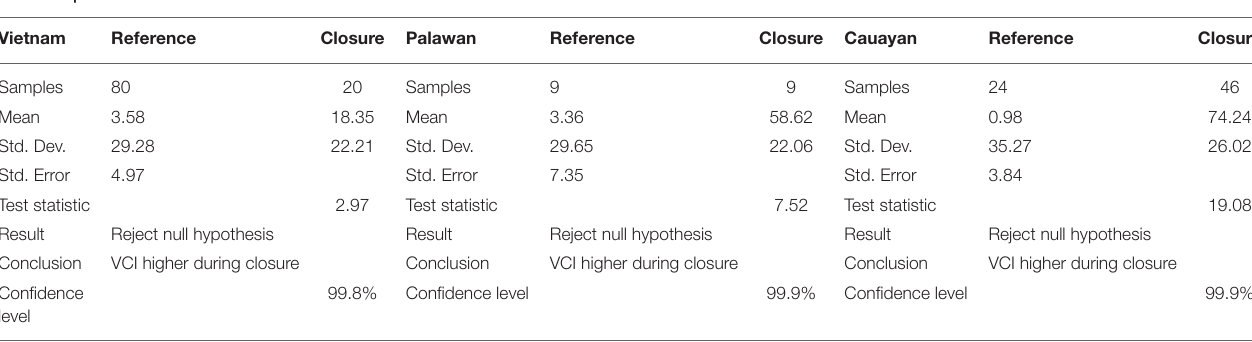
TABLE 3 | Statistical test